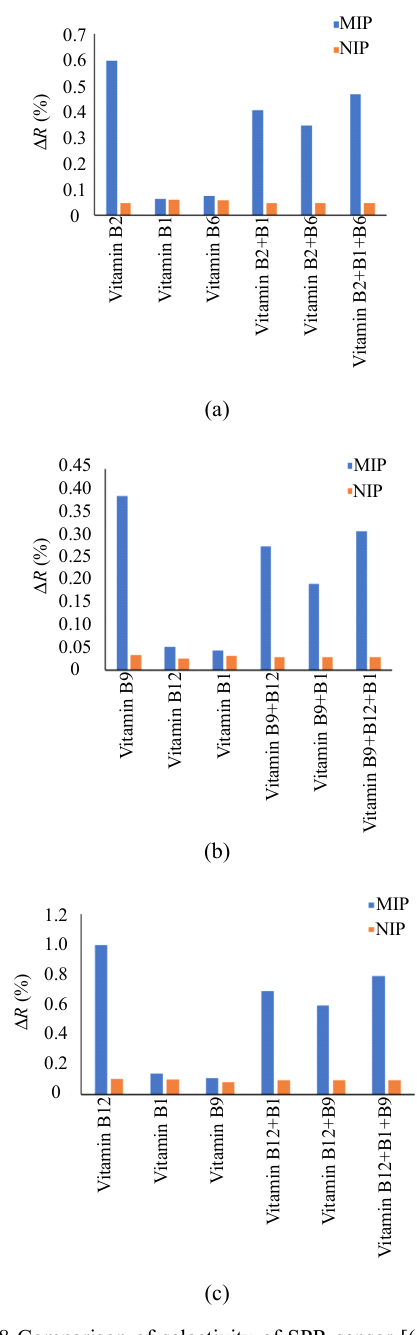
Fig. 8 Comparison of selectivity of SPR sensor [(a) vitamin B2 imprinted SPR sensor, (b) vitamin B9 imprinted SPR sensor, and (c) vitamin B12 imprinted SPR sensor] ( C vitamin B2 : 0.01 ng/mL, C vitamin B9 : 1.0 ng/mL, and C vitamin B12 : 0.1 ng/mL in all